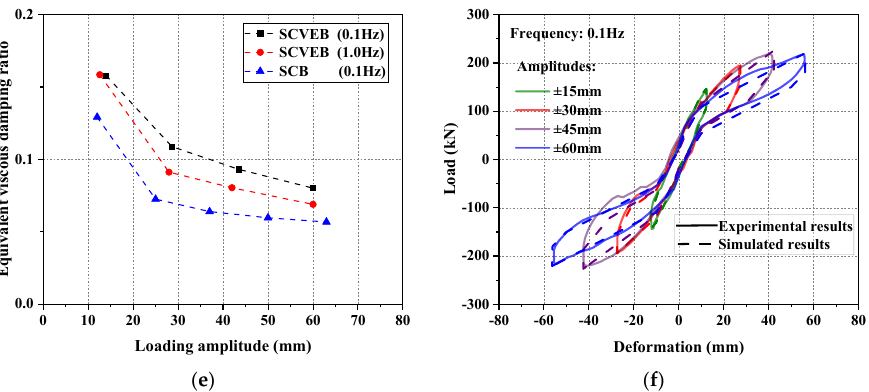
Figure 12. Test results for ( a ) SCVEB-0.1 Hz series, ( b ) SCVEB-1.0 Hz series, ( c ) SCB-0.1 Hz series, ( d ) energy-dissipation per cycle, ( e ) EVD , and ( f ) comparison between the experimental hysteresis loops and the simulated results.